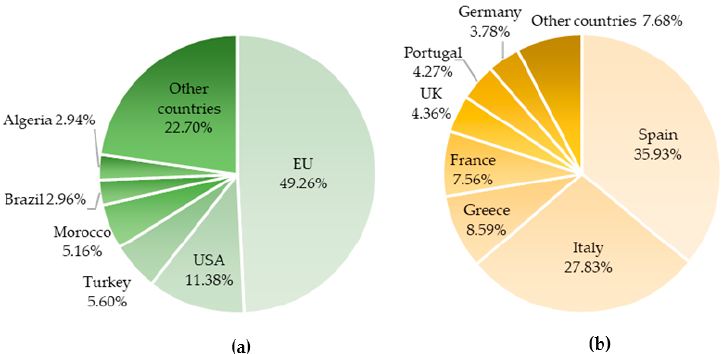
Figure 1. Consumption of olive oil. Provisory data from the campaign year 2018 / 2019: ( a ) World consumption; ( b ) European consumption (data from International Olive Council (IOC) [10]).